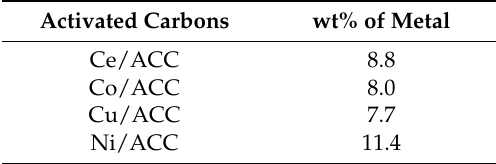
Table 2. Metal content (wt%) of different metals doped on commercial activated carbon catalysts.